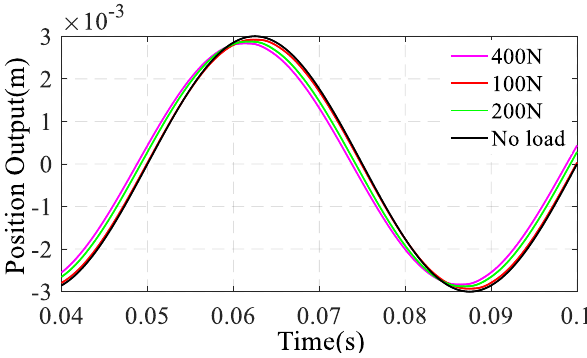
Figure 13. Position outputs under different spring loads.